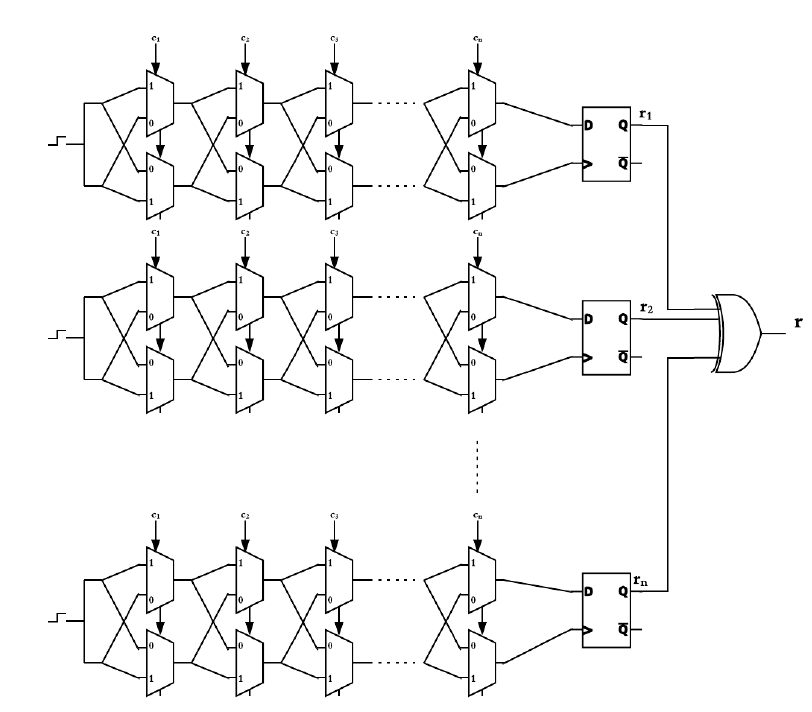
Figure 2. Structure of XOR Arbiter